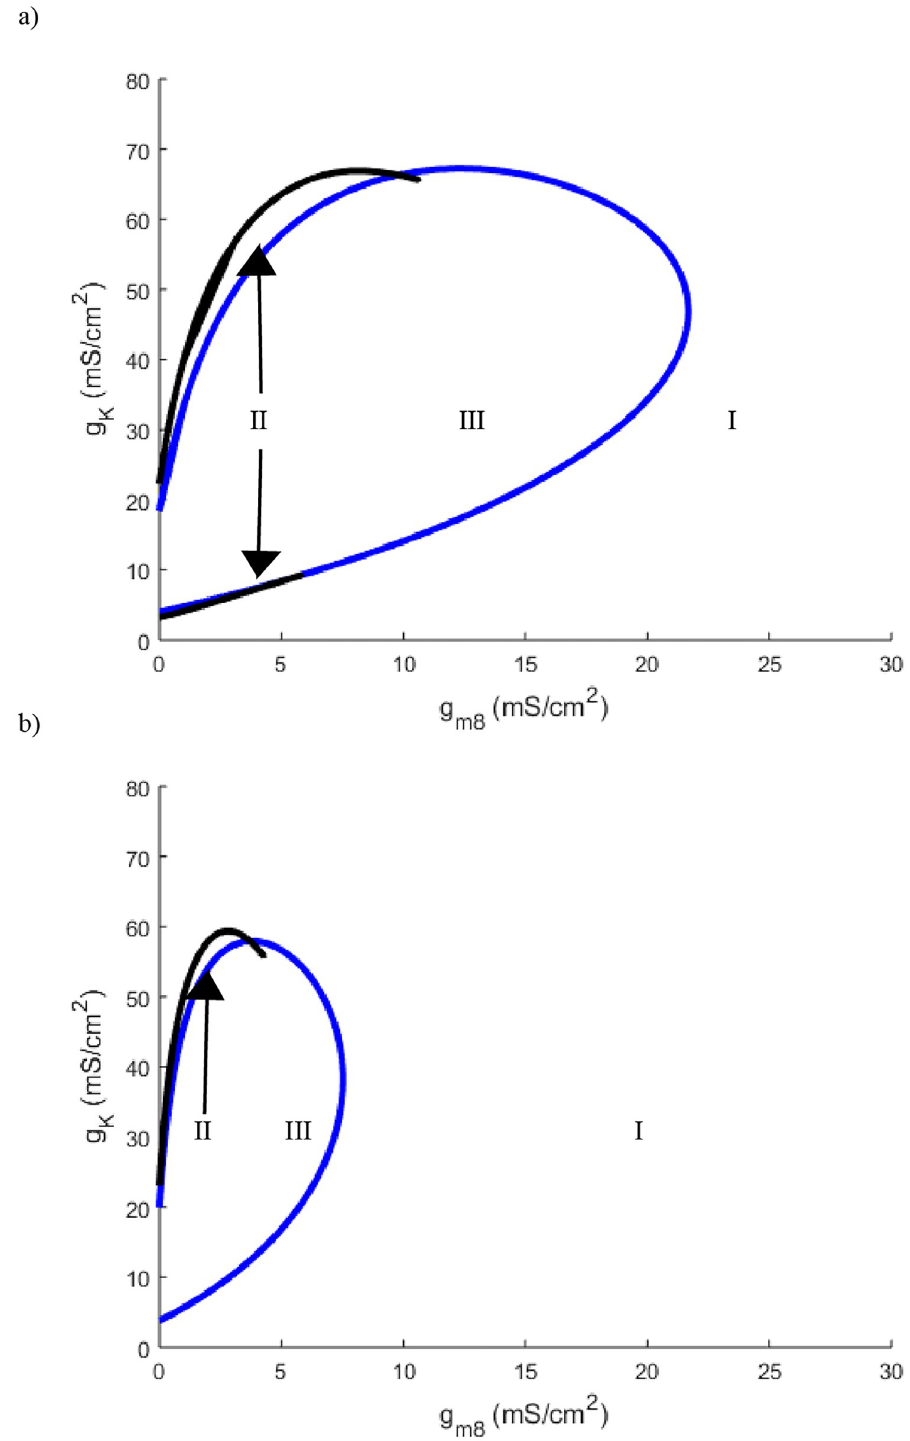
Fig 12. a) Two parameter bifurcation of g m 8 plotted against g K with temperature set to 10˚C. b) Two parameter bifurcation of g m 8 plotted against g K with temperature set to 5˚C. Curve color and labeled regions are identical in meaning to those in Fig 1.